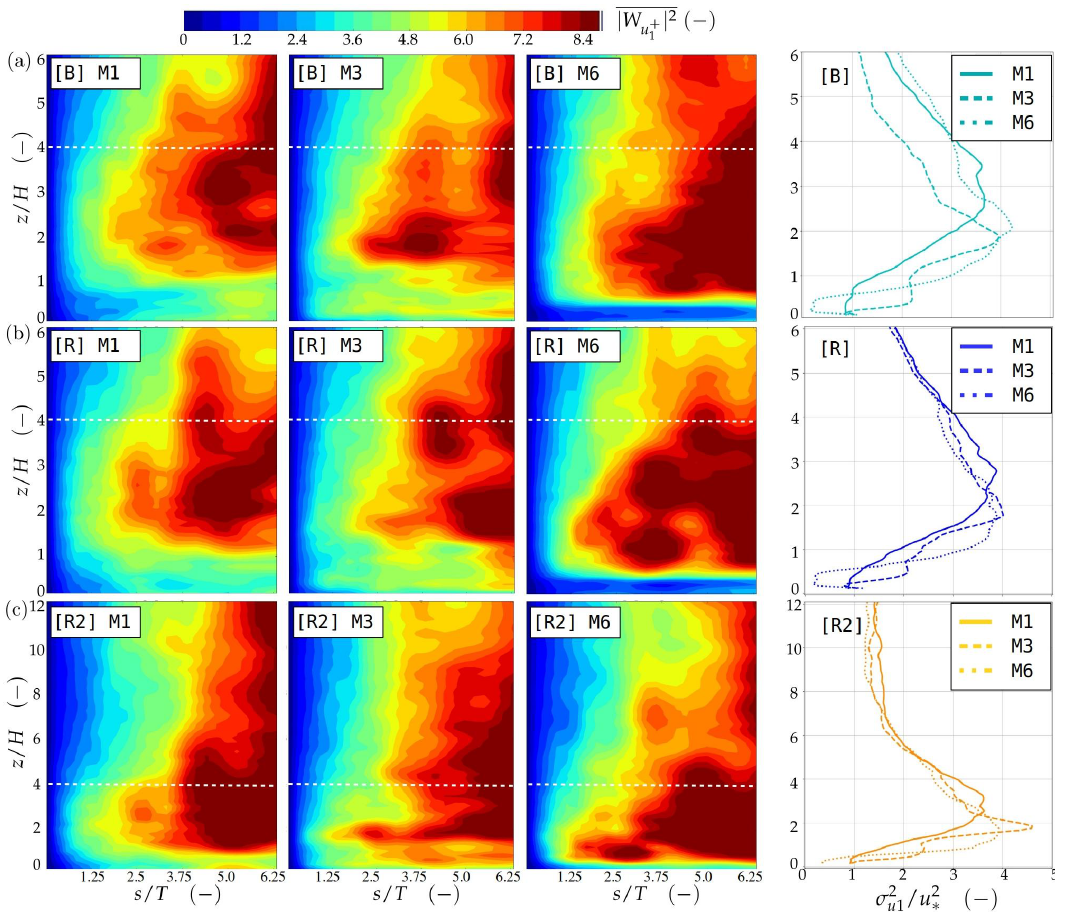
Figure 13. Temporally averaged power scalograms of u + time series obtained from stations M1 , M3 , 1 and M6 , collected from ( a ) case [B] with the largest ABL eddies removed, ( b ) reference case [R] , and ( c ) coarser resolution reference case [R2] , where the data is coincidentally sampled from domain Ω ( 2 ) . Note the vertical extent of the Ω ( 2 ) results is ∼ 12 H , whereas Ω ( 3 ) results are limited to ∼ 6 H . White dashed line highlights z / H = 4 for